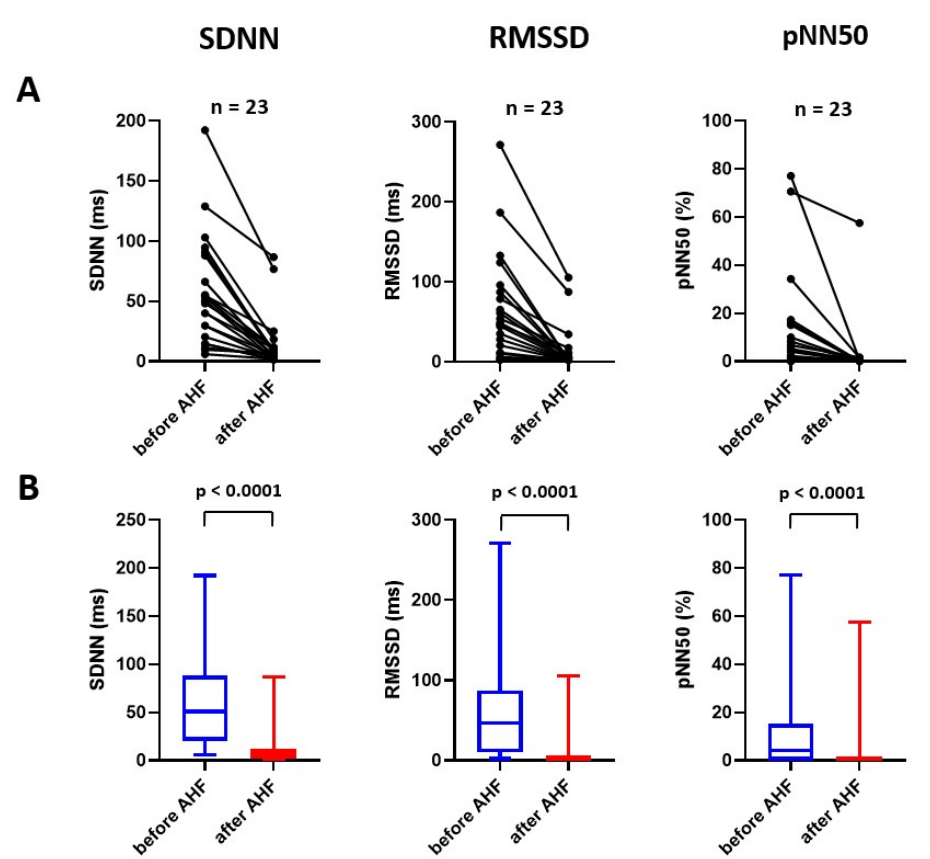
Figure 1. Effect of acute heart failure on time-domain parameters of heart rate variability displayed as an individual graph ( A ) and as median with interquartile range, minimum and maximum value ( B ). AHF = acute heart failure; pNN50 = number of pairs of adjacent NN intervals differing by more than 50 ms divided by the total number of all NN intervals; RMSSD = square root of the mean of the sum of the squares of differences between adjacent NN intervals; SDNN = standard deviation of intervals between normal beats.